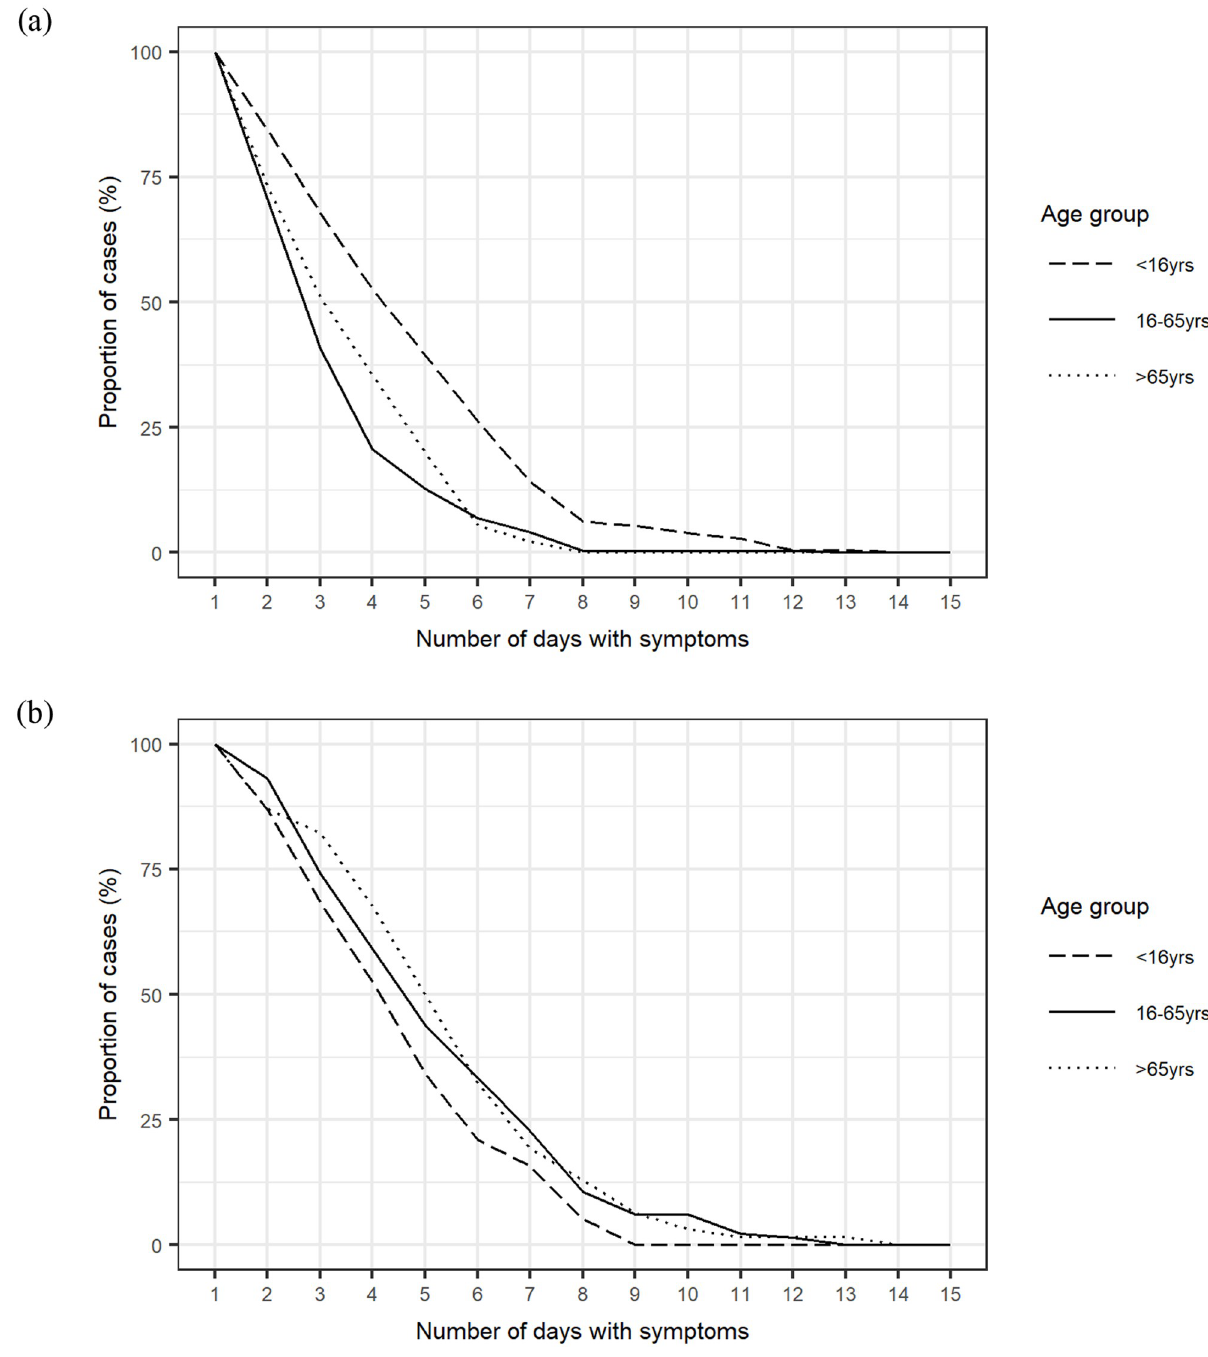
Fig 2. Duration of diarrhoea by age group for a) viral IID and b) bacterial IID.